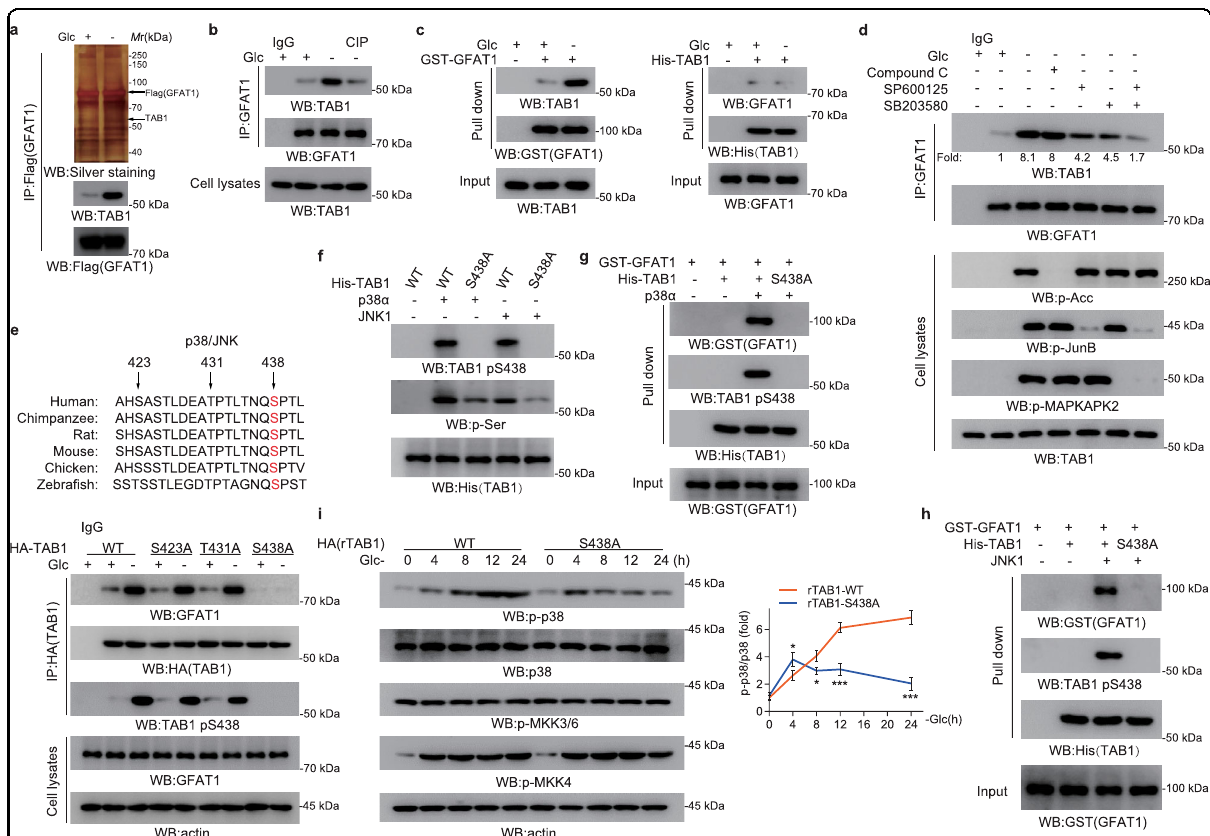
Fig. 2 TAB1 interacts with GFAT1 in a Ser438 phosphorylation-dependent manner. a TAB1 could interact with GFAT1. A549 cells with stable expression of Flag-GFAT1 were cultured for 8 h under glucose deprivation. Immunoprecipitation and immunoblotting analyses were performed using the indicated antibodies. Silver staining analysis of the immunoprecipitates was performed. b TAB1 – GFAT1 interaction was phosphorylation- dependent. A549 cells were cultured for 8 h under glucose deprivation. Immunoprecipitation and immunoblotting analyses were performed using the indicated antibodies. c TAB1 phosphorylation mediated TAB1 – GFAT1 interaction. The indicated puri fi ed GST-GFAT1 or His-TAB1 protein was mixed with cell lysates from A549 cells cultured for 8 h under glucose deprivation. Pull-down and immunoblotting analyses were performed using the indicated antibodies. d JNK/p38 mediated TAB1 – GFAT1 interaction. A549 cells were pretreated with Compound C (10 μ M), SP600125 (20 μ M), and SB203580 (10 μ M) for 1 h before being cultured for 8 h under glucose deprivation. Immunoprecipitation and immunoblotting analyses were performed using the indicated antibodies. e Ser438 of TAB1 is evolutionarily conserved in the indicated species (upper panel). TAB1 Ser438 phosphorylation mediated TAB1 – GFAT1 interaction. A549 cells with transient expression of WT TAB1, TAB1-S423A, TAB1-T431A or TAB1-S438A were cultured for 8 h under glucose deprivation. Immunoprecipitation and immunoblotting analyses were performed using the indicated antibodies (lower panel). f His-TAB1 Ser438 could be phosphorylated by p38 α or JNK1. Puri fi ed His-TAB1 proteins were subjected to in vitro kinase assay. g , h In vitro binding of His-TAB1 and GST-GFAT1. Puri fi ed His-TAB1 WT and His-TAB1-S438A protein with phosphorylation by p38 α ( g ) or JNK1 ( h ) was mixed with puri fi ed GST-GFAT1. Pull-down and immunoblotting analyses were performed using the indicated antibodies. i Expression of rTAB1-S438A inhibited p38 activation at late time points. A549 cells with depleted TAB1 and reconstituted expression of WT rTAB1 or rTAB1-S438A were cultured for indicated time under glucose deprivation. Immunoblotting analyses were performed using the indicated antibodies. In i , the values are presented as means ± SEM, n = 3; * P < 0.05, *** P < 0.001, Student ’ s t -test,